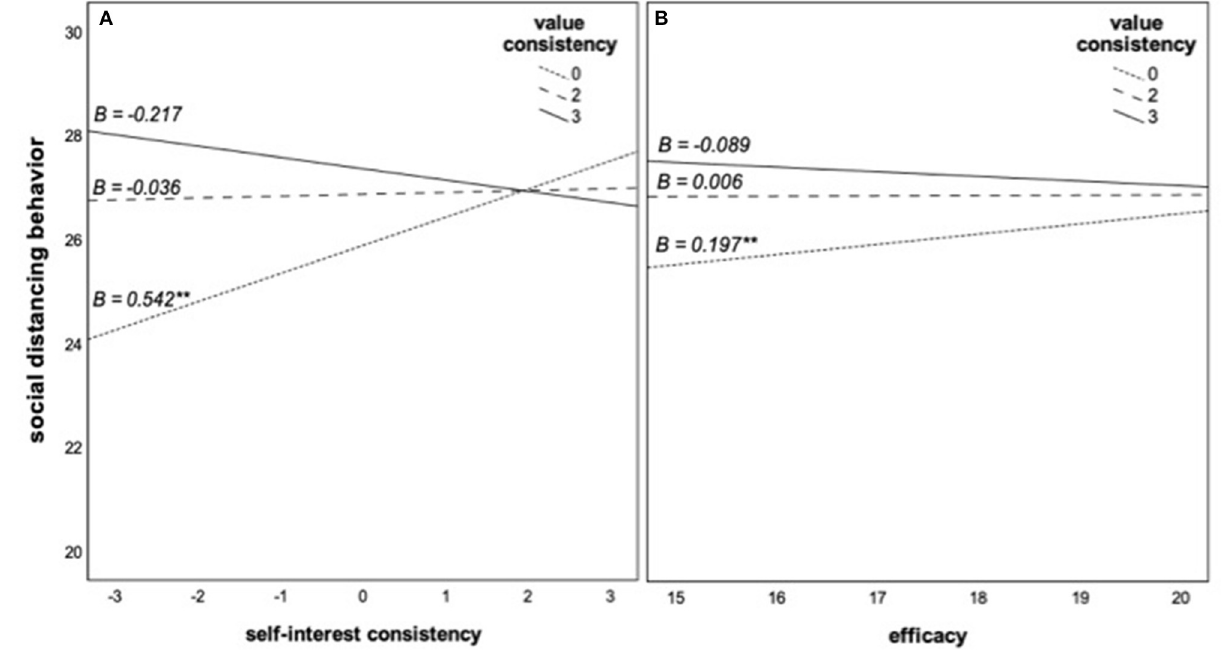
FIGURE 2 | (A,B) Role of self-interest consistency and efficacy for social distancing behaviors at different levels of value consistency. The slopes represent the estimated conditional effects at the 16, 50, and 84th percentiles of the moderator value consistency. A value of 0 means that participants perceived social distancing as neither consistent nor inconsistent with their personal values. A value of 3 means that participants considered social distancing as completely consistent with their personal values. ** p <